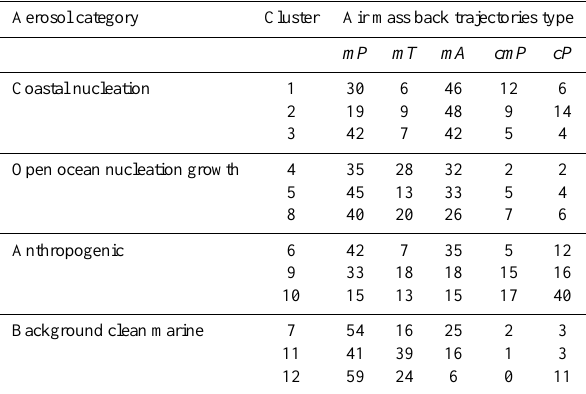
Table 2. Occurrence (%) of the five different air mass back trajec- tories type described in Dall’Osto et al. (2010) for each of the 12 SMPS clusters. Air mass back trajectories were calculated every six hours (00:00a.m., 06:00a.m., 12:00p.m., 06:00p.m.) for the whole year of 2008.